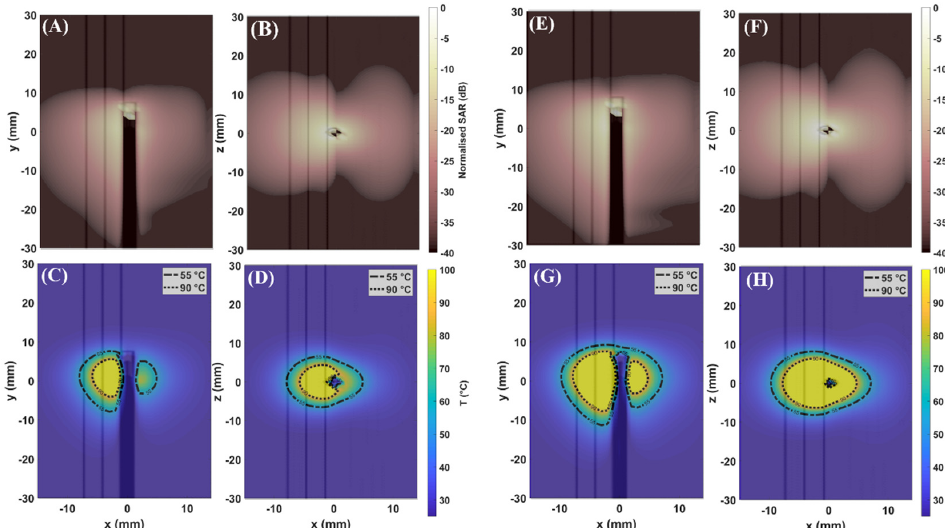
Figure 3. Maps of SAR: ( A , E ) (xy–plane); ( B , F ) (xz–plane) and maps of temperature: ( C , G ) (xy–plane); ( D , H ) (xz–plane), obtained in simplified model at 30 W and 60 W at 5.8 GHz. The applicator is aligned at the interface between fat and adrenal gland (Figure 1A). The longitudinal axis of the applicator is parallel to the